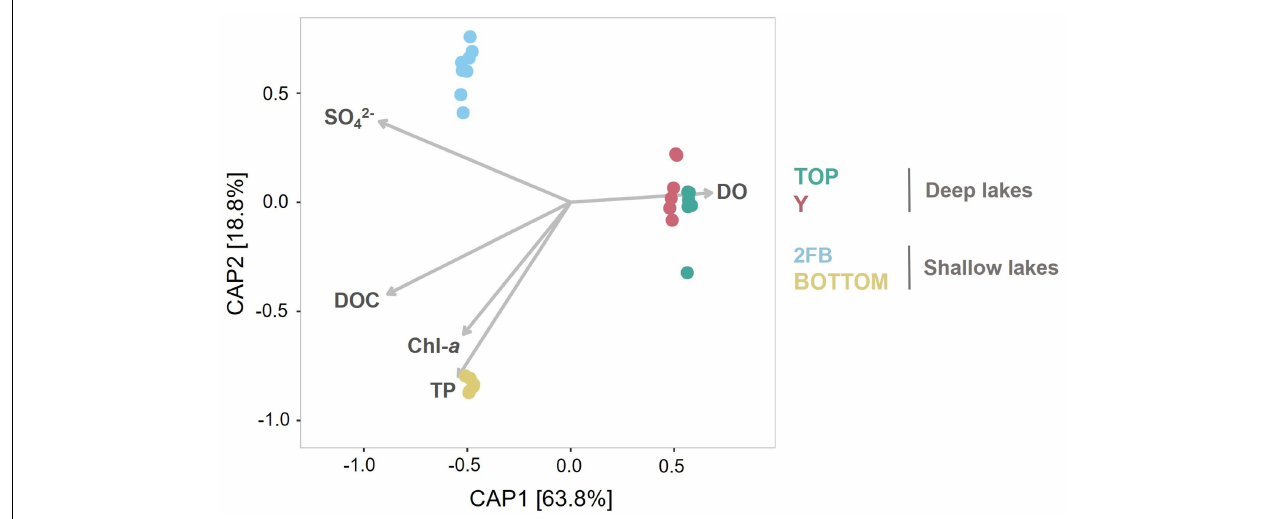
FIGURE 4 | Constrained analysis of principal coordinates of the lake microbial community composition constrained to five environmental variables. Vectors for dissolved oxygen (DO), dissolved organic carbon (DOC), total phosphorus (TP), chlorophyll a (Chl- a ) and the sulfate concentrations (SO 42 − ) illustrate correlations between samples and each of these limnological properties. Colors are associated with each lake: turquoise, Top; pink, Y; blue, 2FB; yellow, Bottom. Note that each sample had two replicates (except 0 m in Top